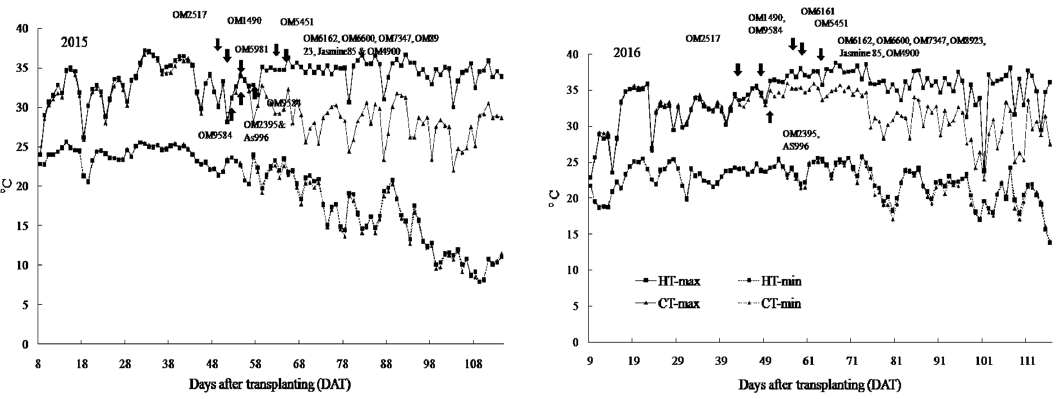
Figure 1. Changes in maximum and minimum temperature under control and high temperature treatments in 2015 and 2016. Arrows indicate the heading time.